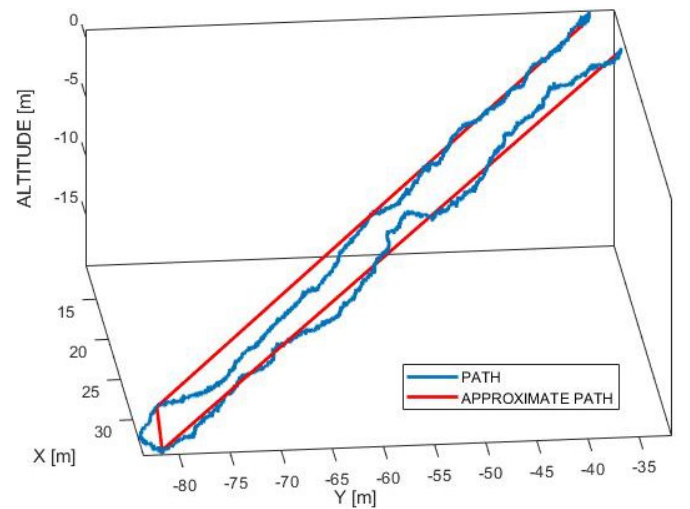
Figure 14. Path followed by the robot in the vineyard with steep slope. The X and Y positions were obtained from GPS and the altitude was calculated by the static pressure sensor (blue). The approximate path is shown in